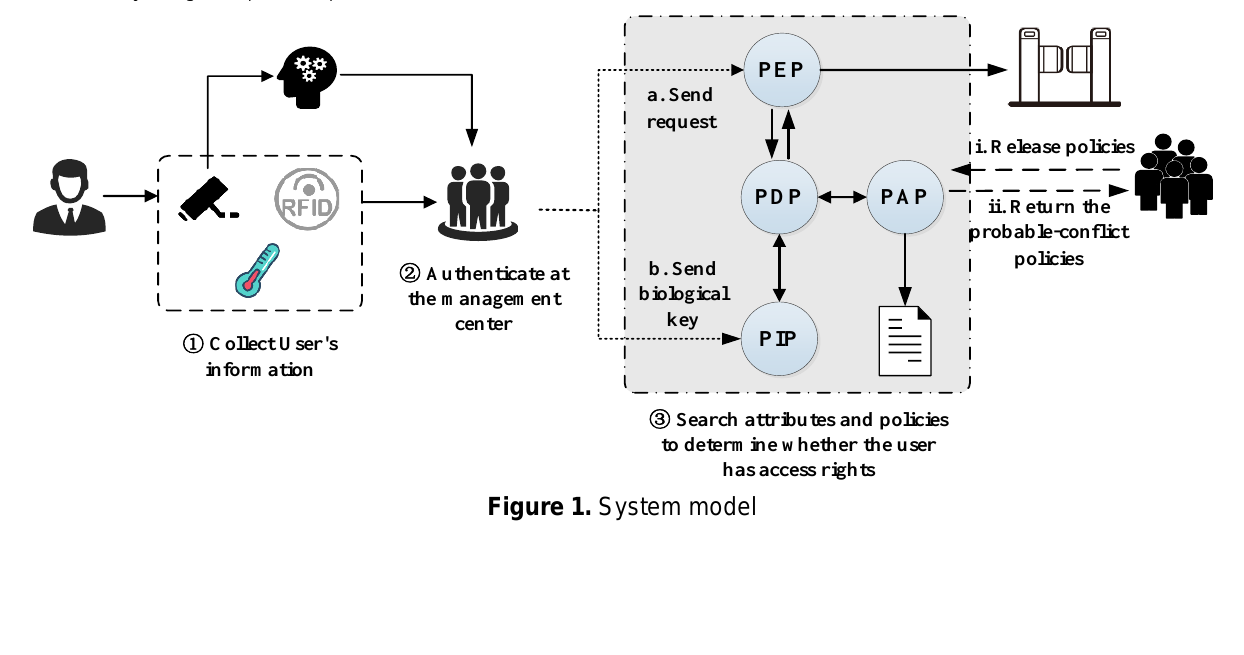
Figure 1. System